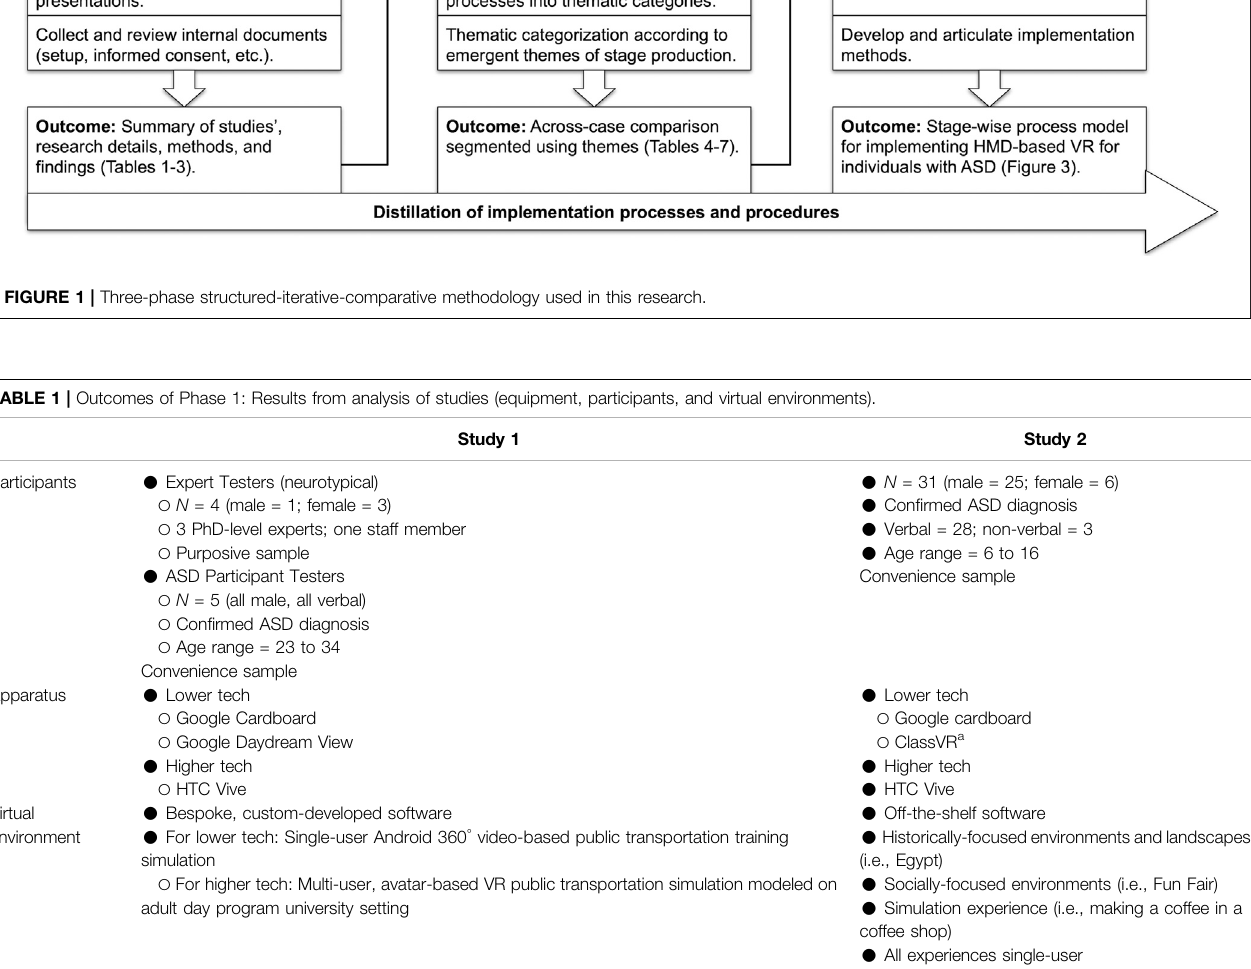
the nature of participants ’ user experience, feasibility, and relevance of a spherical, video-based virtual reality (SVVR) app as well as a fully immersive, collaborative 3D virtual environment, both of which were delivered using HMDs for a